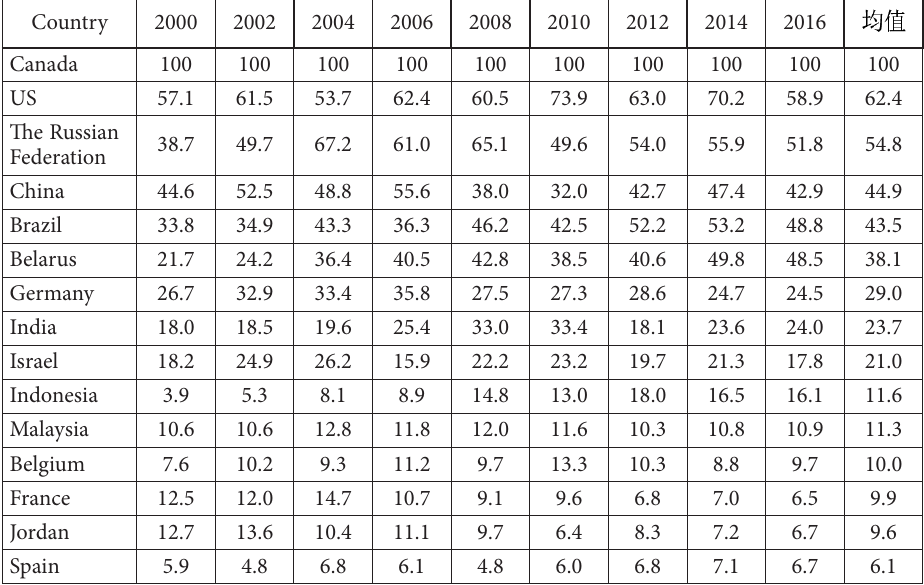
Figure 13. Evolution of trade influence index of trade leading countries and dominant countries Table 4. Trade influence index